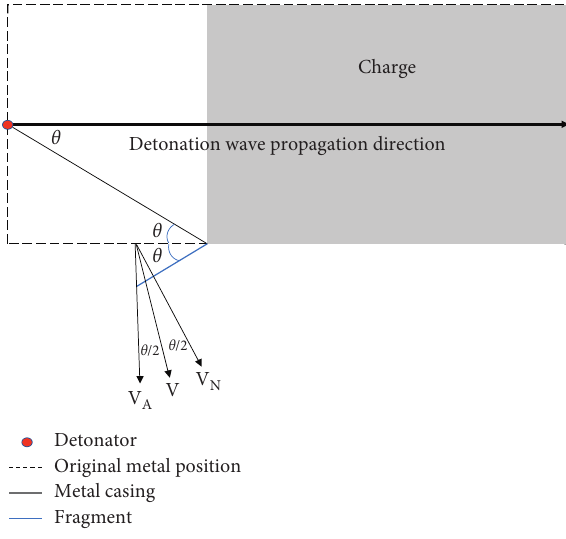
Figure 1: Variables used in Taylor